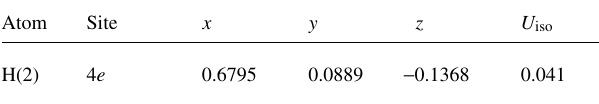
Table 2. Atomic coordinates and displacement parameters (in Å 2 )